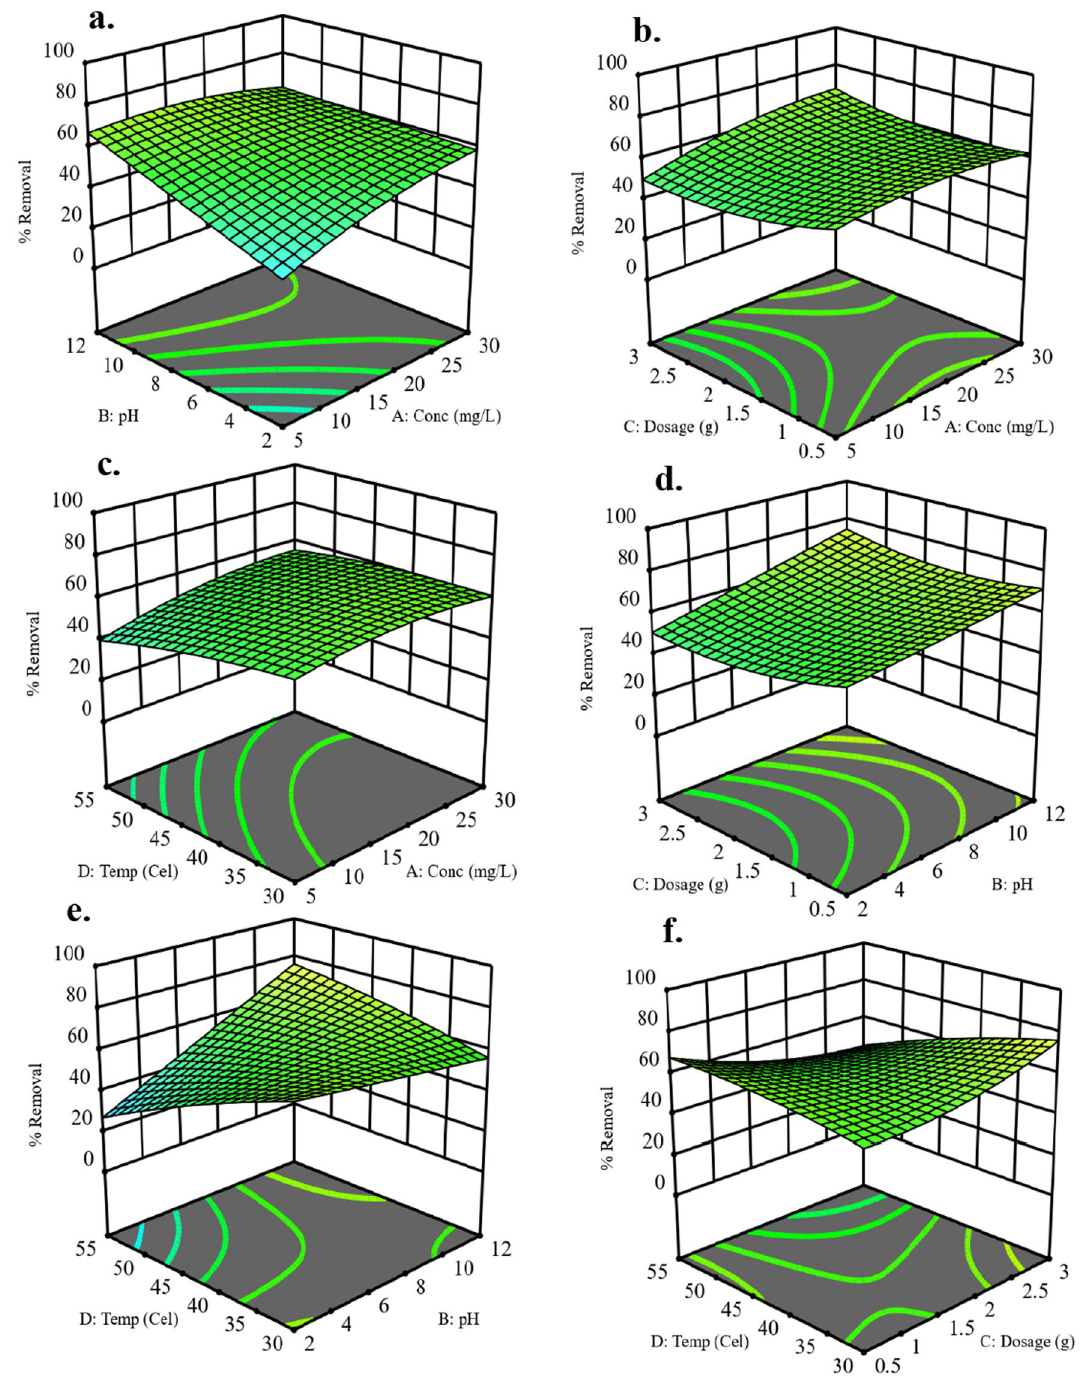
Fig. 8 a 3D plots of interaction of ( a ) concentration, pH. b Concentration, dosage. c Temperature, concentration. d Concentration, pH. e Temperature, pH; and ( f ) temperature,